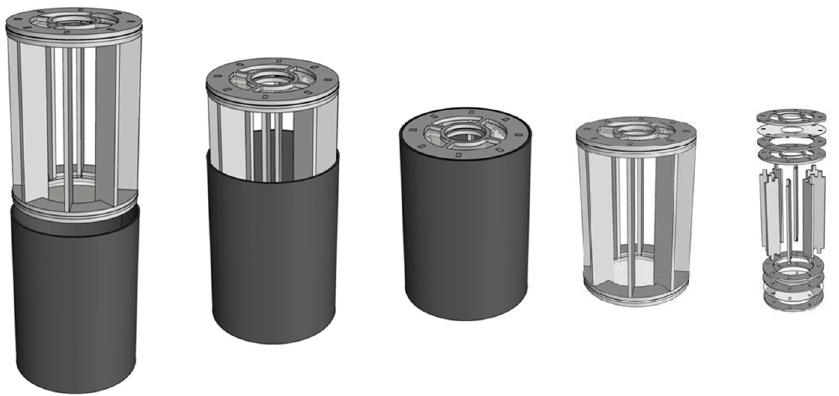
Figure 1. Two-piece tube container featuring an external piece: pipe connection socket; and an internal piece: two methacrylate rings joined together by eight methacrylate strips.